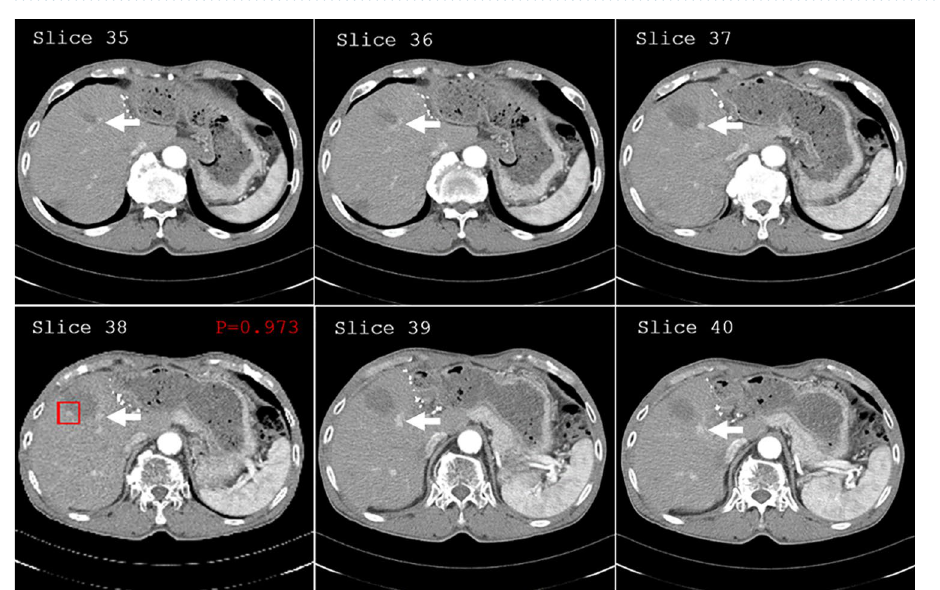
Figure 2. Prediction map for true positive predicted LTP region. In the prediction map, we report the rectangular region of interest on the axial slice of the whole CT scan, slide number, tumor prediction probability, as well as neighboring image slices included in the positive-predicted regions. LTP was detected (red rectangular), and hepatic vessels including hepatic artery and portal vein (arrows) were not indicated in the prediction